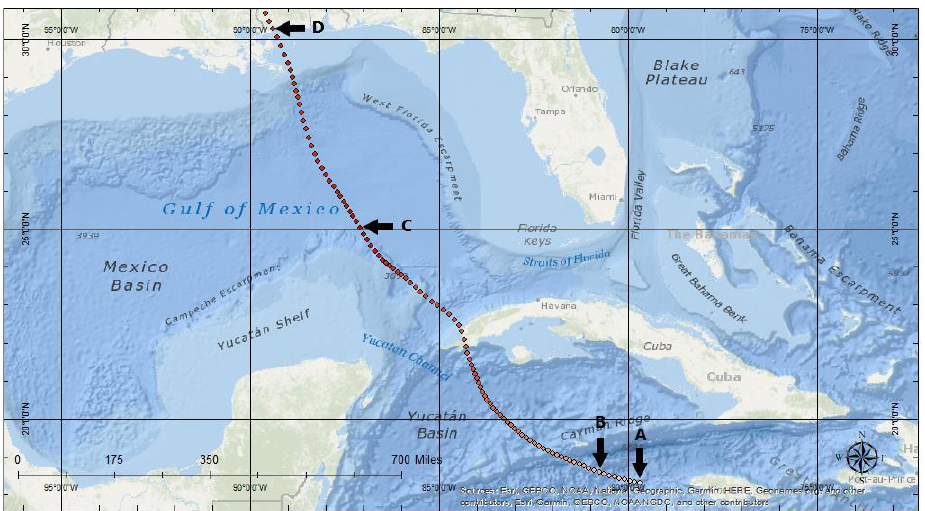
Figure 2. Schematic of defined rapid intensification (RI) hurricane processes using Hurricane Camille’s track in 1969 as an example. ( A ) Hurricane origin point, ( B ) RI genesis point, ( C ) lifetime maximum intensity (LMI) point, and ( D ) landfall point. Table 1. Comparison of Gulf of Mexico, North Atlantic, and Caribbean rapid intensification (RI) storm origins and RI genesis